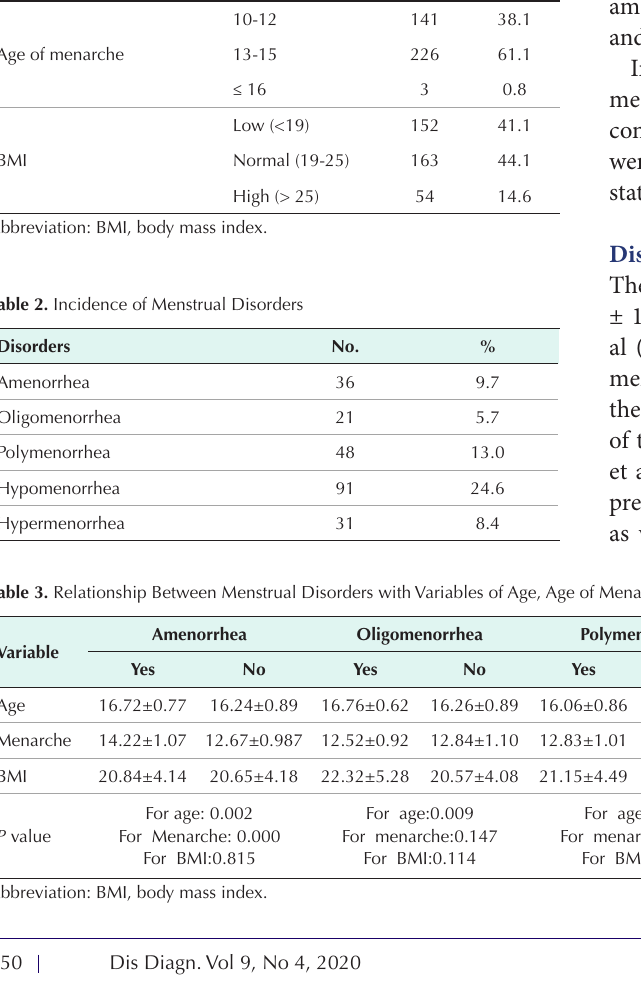
Table 1. Frequency Distribution of Students Under Study Based on Age of Menarche and BMI Personal Characteristics